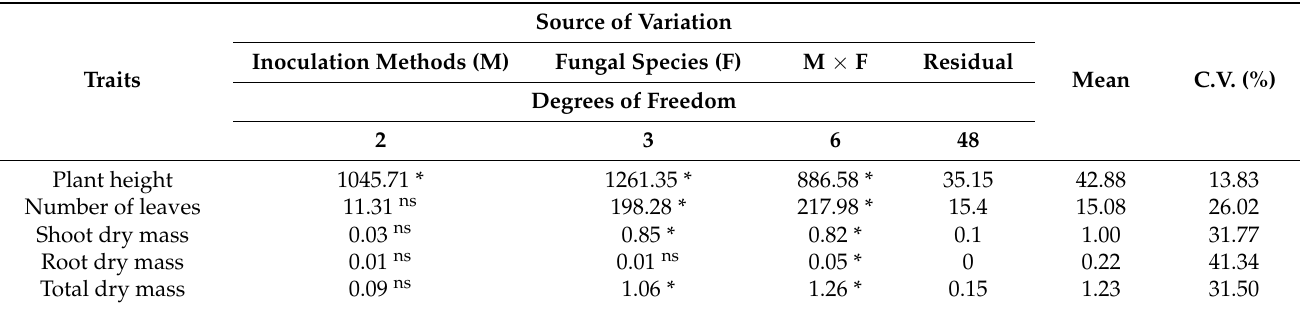
Metarhizium anisopliae , and Trichoderma strigosellum ).